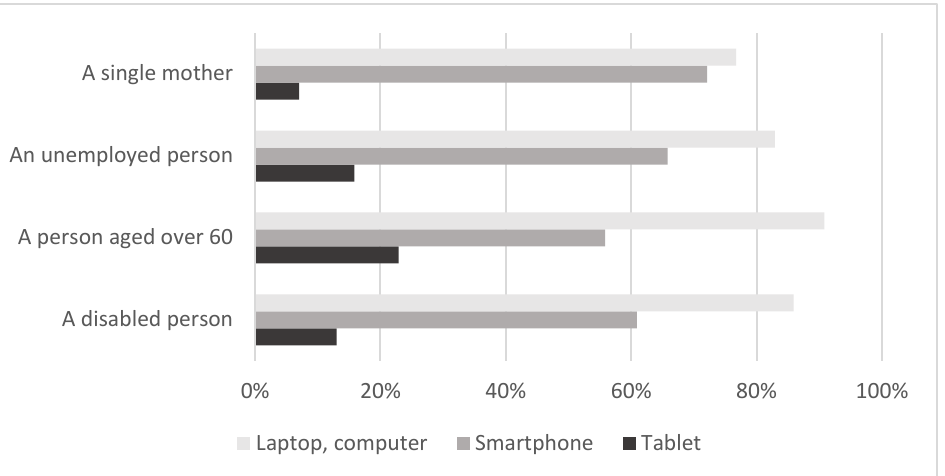
Figure 4. A device for access the internet by social status of the respondents ( n = 521) (source, own research). Note: adds up to 100% as respondents were free to indicate more than one device.